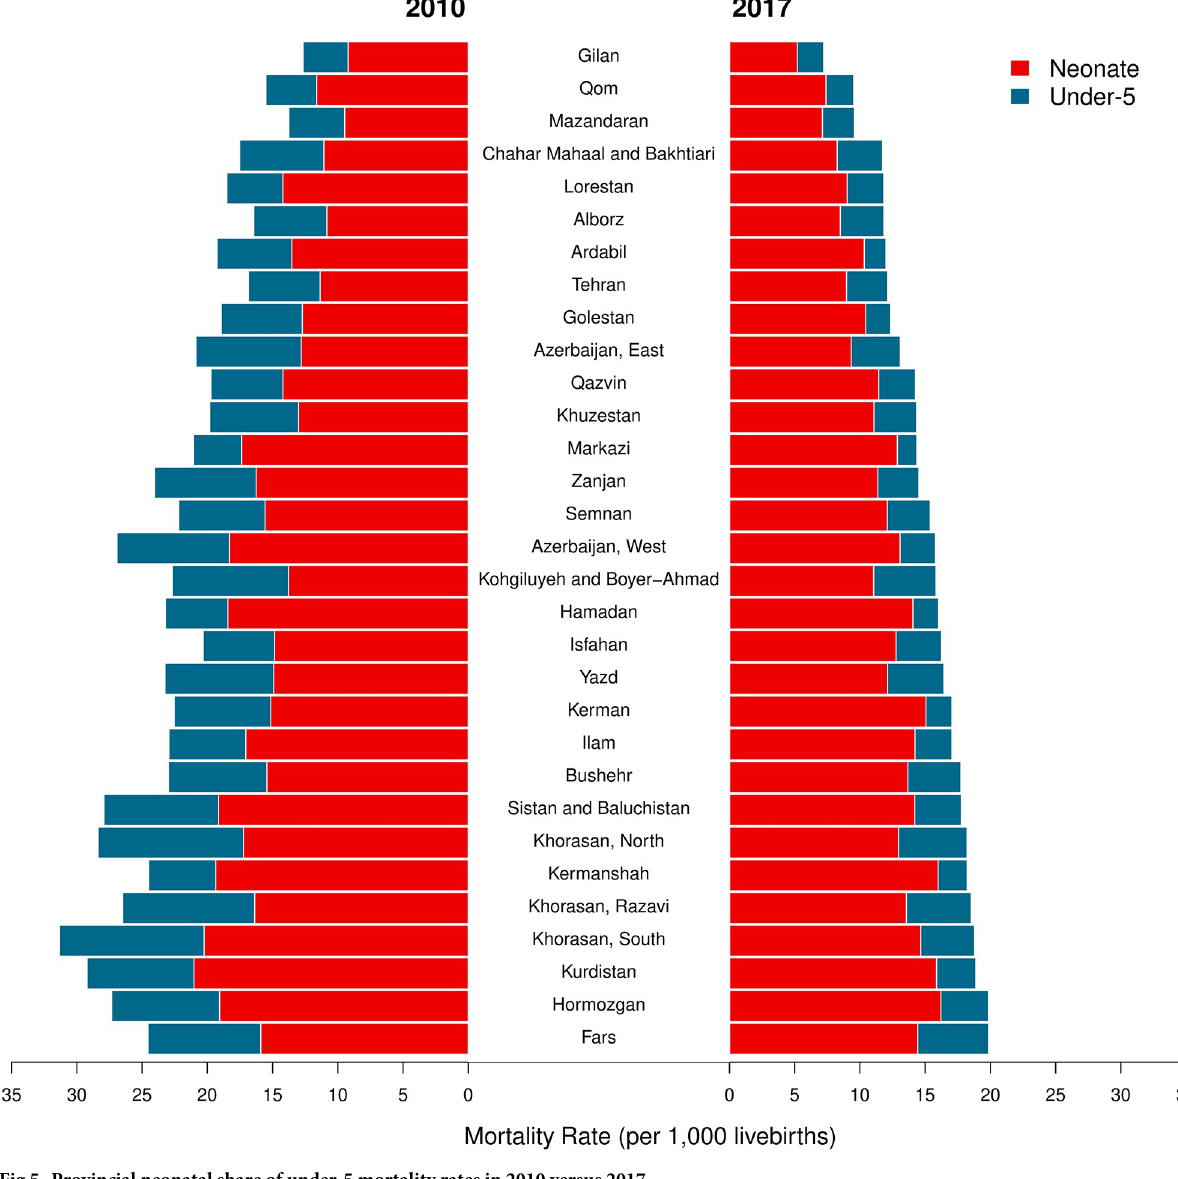
Fig 5. Provincial neonatal share of under-5 mortality rates in 2010 versus